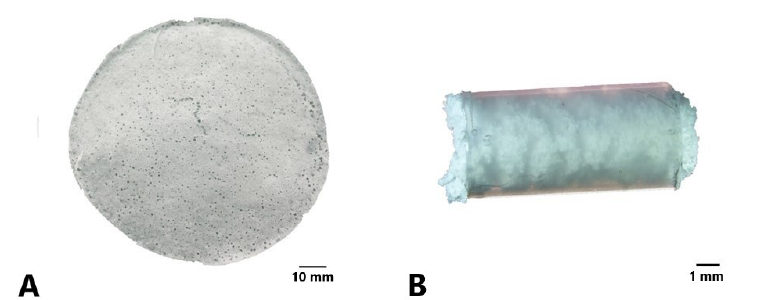
Figure 1. The photo images of porous PHB scaffolds. ( A ) Scaffold-1. ( B ) Scaffold-2.